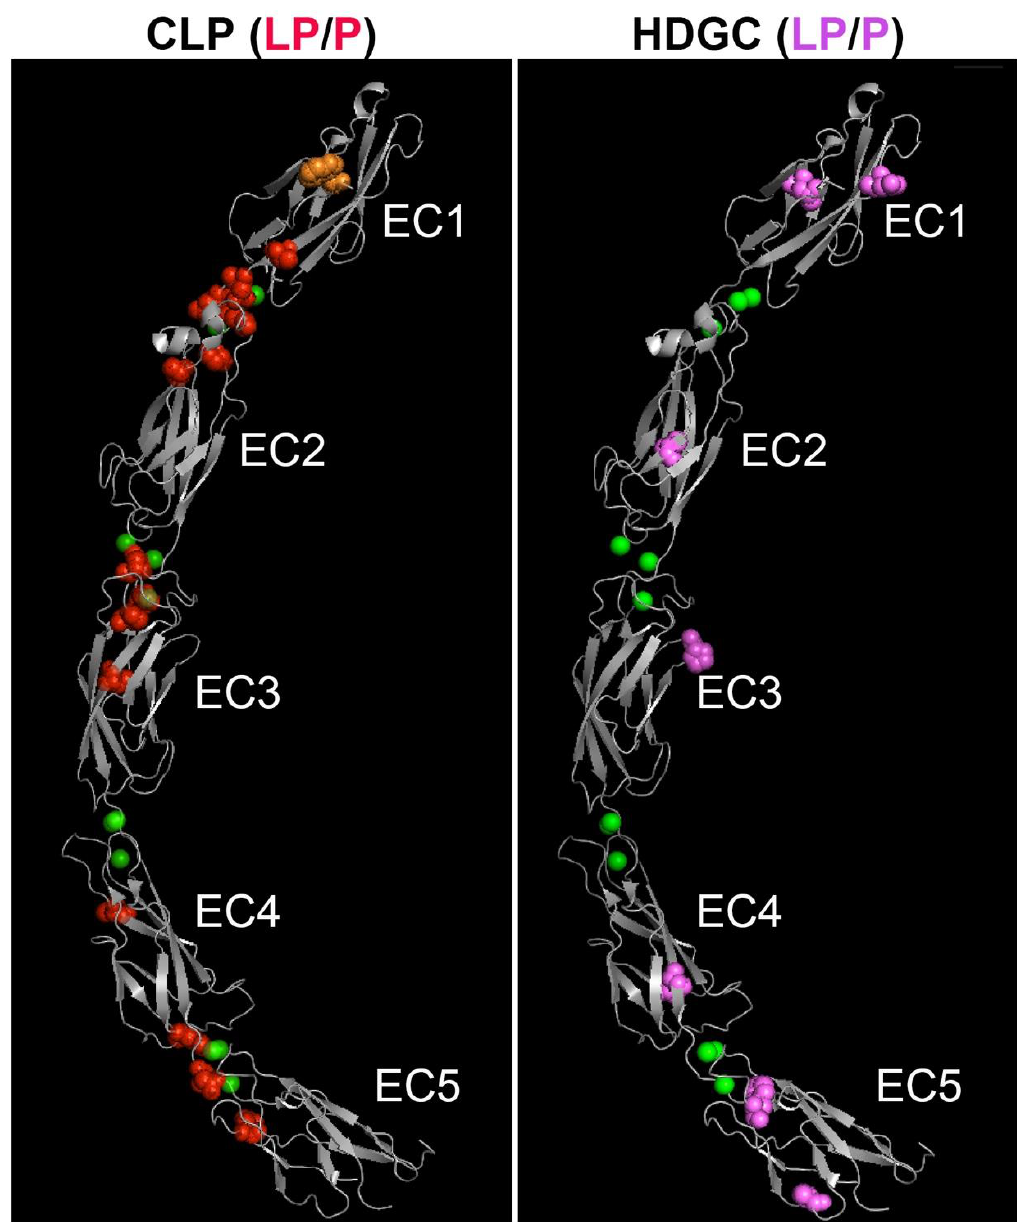
Figure 3. Homologous location of likely pathogenic and pathogenic human missense and in-frame deletion variants causing CL / P (left panel) and HDGC (right panel) on the three-dimensional ectodomain structure of E-cadherin. The extracellular region of mature mouse E-cadherin (PDB 3Q2V) [3], comprised of five EC domains, is shown in grey. The positions of CL / P variants are shown as red spheres (left image); HDGC variants are shown as pink spheres (right image). The location of the CL / P variant in the tryptophan (W156) that is critical for in trans interaction of E-cadherin is shown in orange. Chelated calcium ions are shown as green spheres. Note apparent clustering of CL / P variants around the linker regions, in contrast to the HDGC variants. LP / P—likely pathogenic / pathogenic.